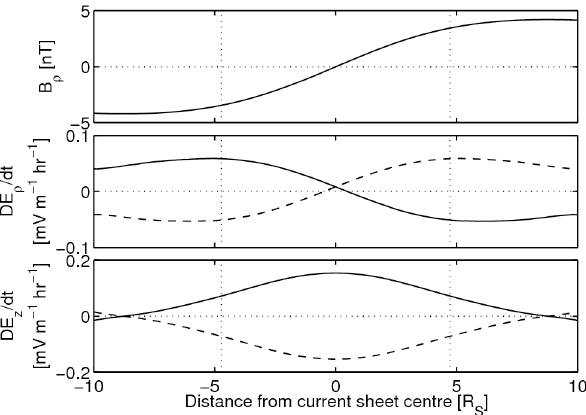
Figure 3: Calculated electric field derivatives as a function of axial distance from the centre of the current and plasma sheet. The top panel shows the radial component of the field for reference. The middle and bottom panels show the total time derivative of the radial and axial components of the electric field. The vertical dotted lines show the extents of the current sheet. The solid lines show the rate of change of the electric field when the sheet is in rapid axial motion downwards (u z <0) and the dashed line when the sheet is moving upwards (u z >0).